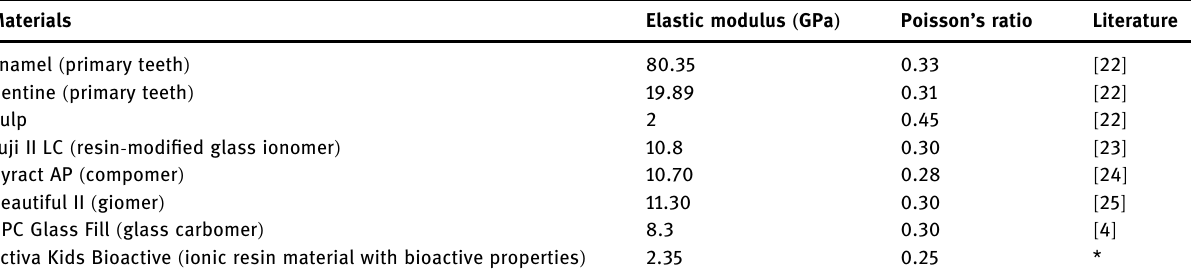
Table 1: Mechanical properties of the tooth and restorative materials Materials